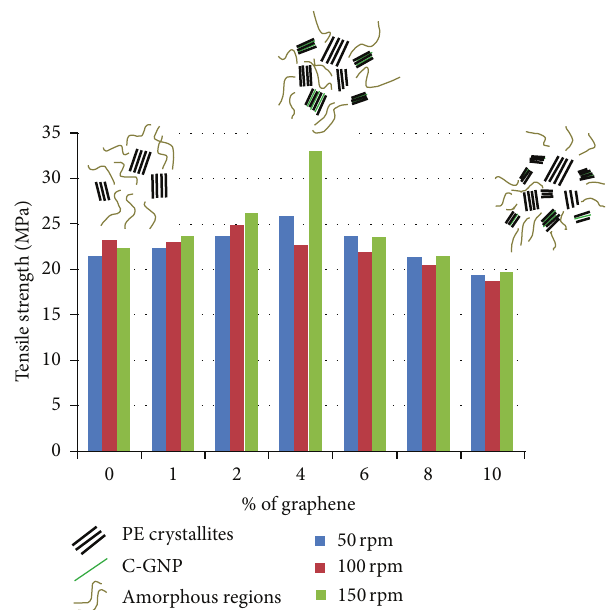
Figure 12: Effect of graphene filler content on tensile strength of LLDPE/C-GNPs composites at different screw/feeder speeds with the schematic diagram of morphology of the C-GNPs/LLDPE composites.